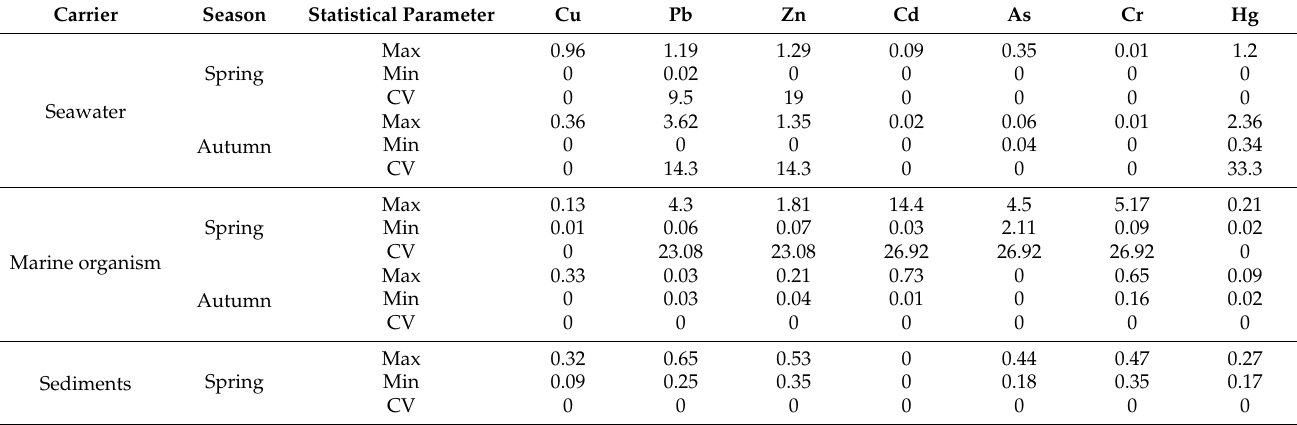
Table 1. Results of single pollution index